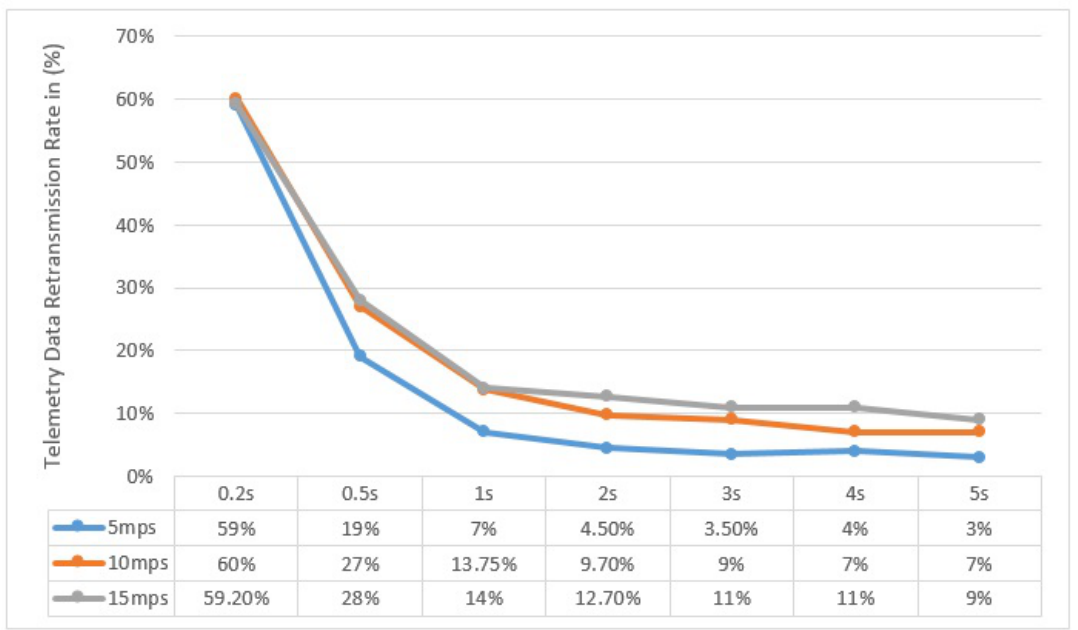
Figure 16. Re-transmission Rate of UAV to BS Communication for different UAV speed and Flush Back